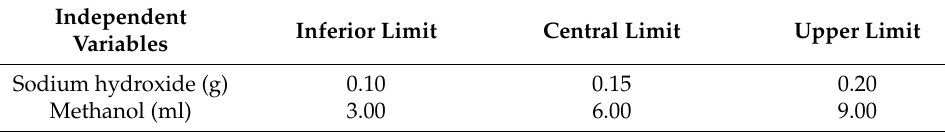
Table 1. Independent variables and their respective experimental limits.